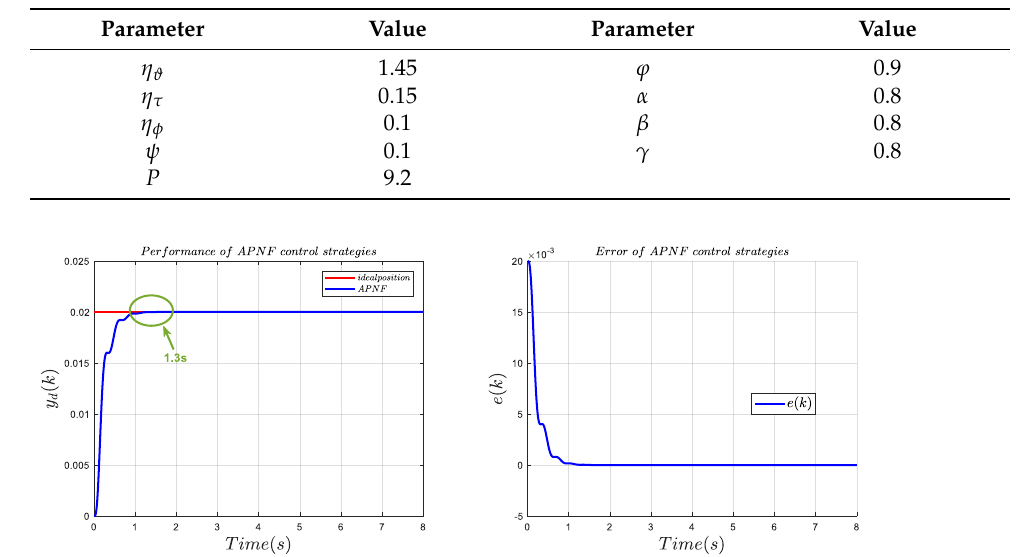
Table 1. Parameters involved in APNF model.